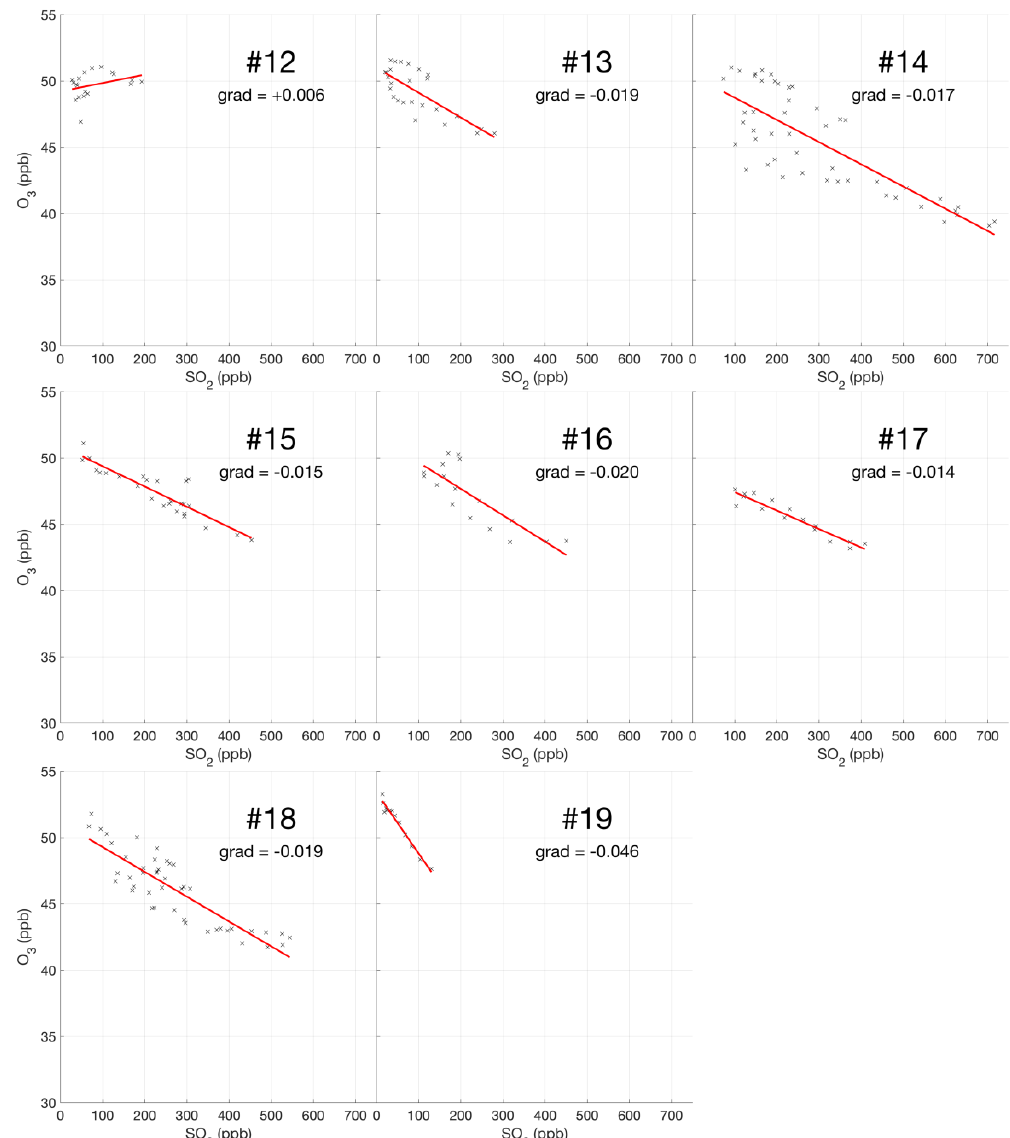
Figure 5. Measurements of SO 2 and O 3 mixing ratios for the eight major plume encounters on 1 August